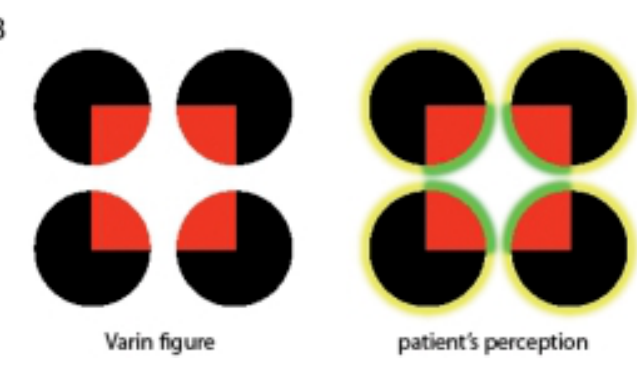
Fig. 1. (A) Simulation of the patient’s visual disturbances using image processing. The patient claims that she always sees dazzling spots in the air, similar to the reflection of the water. She also sees afterimages of what she just saw, frequently in the inverted color (see the letters, “ABCDEFG”), and the afterimages last for a long time. The simulation of her visual symptoms was done by processing the digital images with the patient. The patient confirmed that the pictures exactly replicated her visual experiences. (B) Varin figure (left) and the patient’s perception of the figure (right). In the left figure, an illusory red square is perceived by normal subjects. Note that the edges of the original Varin figure are surrounded by the “coronas” in the complementary color in the right figure. (C) The patient’s drawing of her scintillating scotoma with paint and a photograph. Note that the center of the picture is blank and the white area has a corrugated